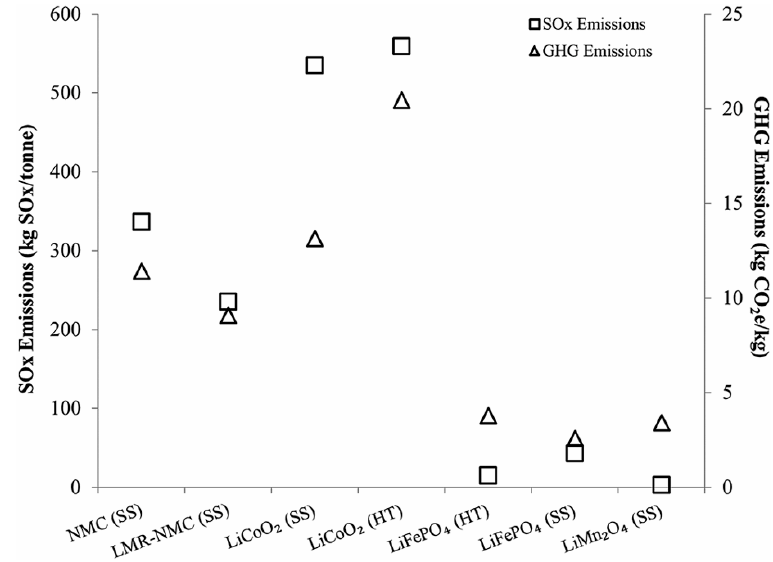
Figure 4. Gas emissions for synthesis methods for various active materials (reproduced with permission from The Royal Society of Chemistry Ref. [38]); here, NMC and LMR-NMC are lithium- nickel-manganese-cobalt oxide and Li and Mn-rich lithium-nickel-manganese-cobalt oxide; SS and HT are solid state and hydrothermal synthesis methods; and GHG is greenhouse gas.